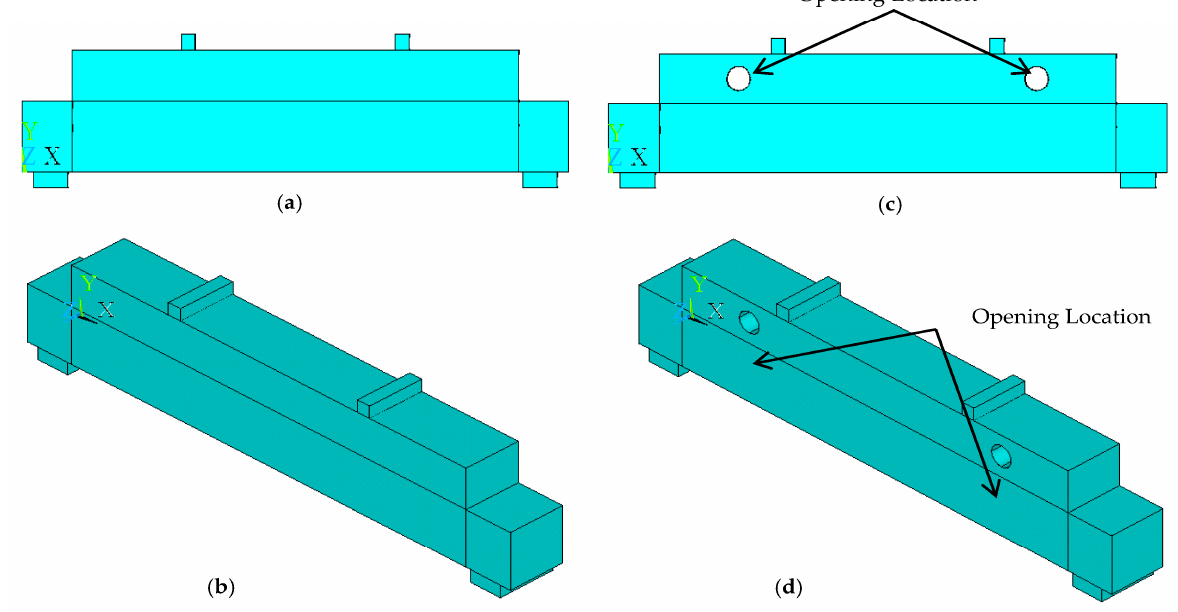
Figure 9. Numerical modelling steps for typical RC girders with dapped ends. ( a ) 2D area (Solid). ( b ) 3D volume (Solid). ( c ) 2D area (Opening). ( d ) 3D volume (Opening).